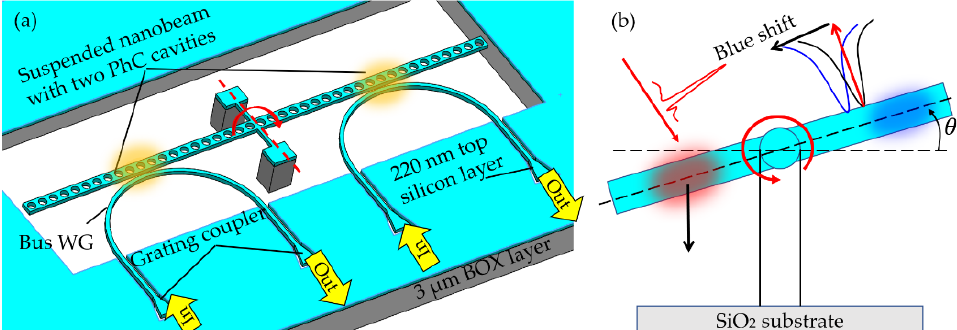
Figure 21. Optomechanical torsion sensor: ( a ) a suspended nanobeam inscribed with PhC cavities at each side; ( b ) laser detuning of mechanical twisting of nanobeam [127] .